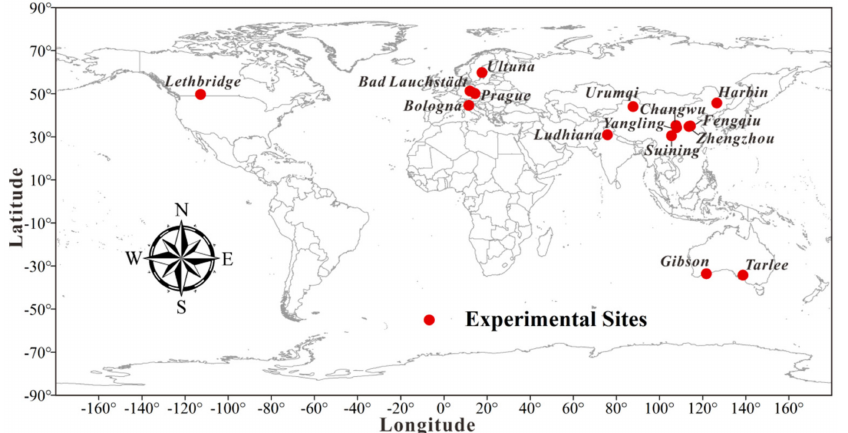
Figure 1. The location of field experiments at 15 sites across the globe.